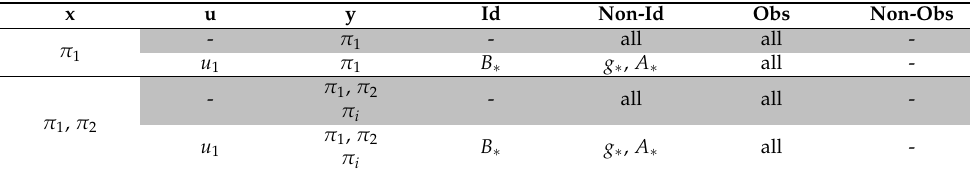
Table 2. cLV. Results for the composite Lotka–Volterra